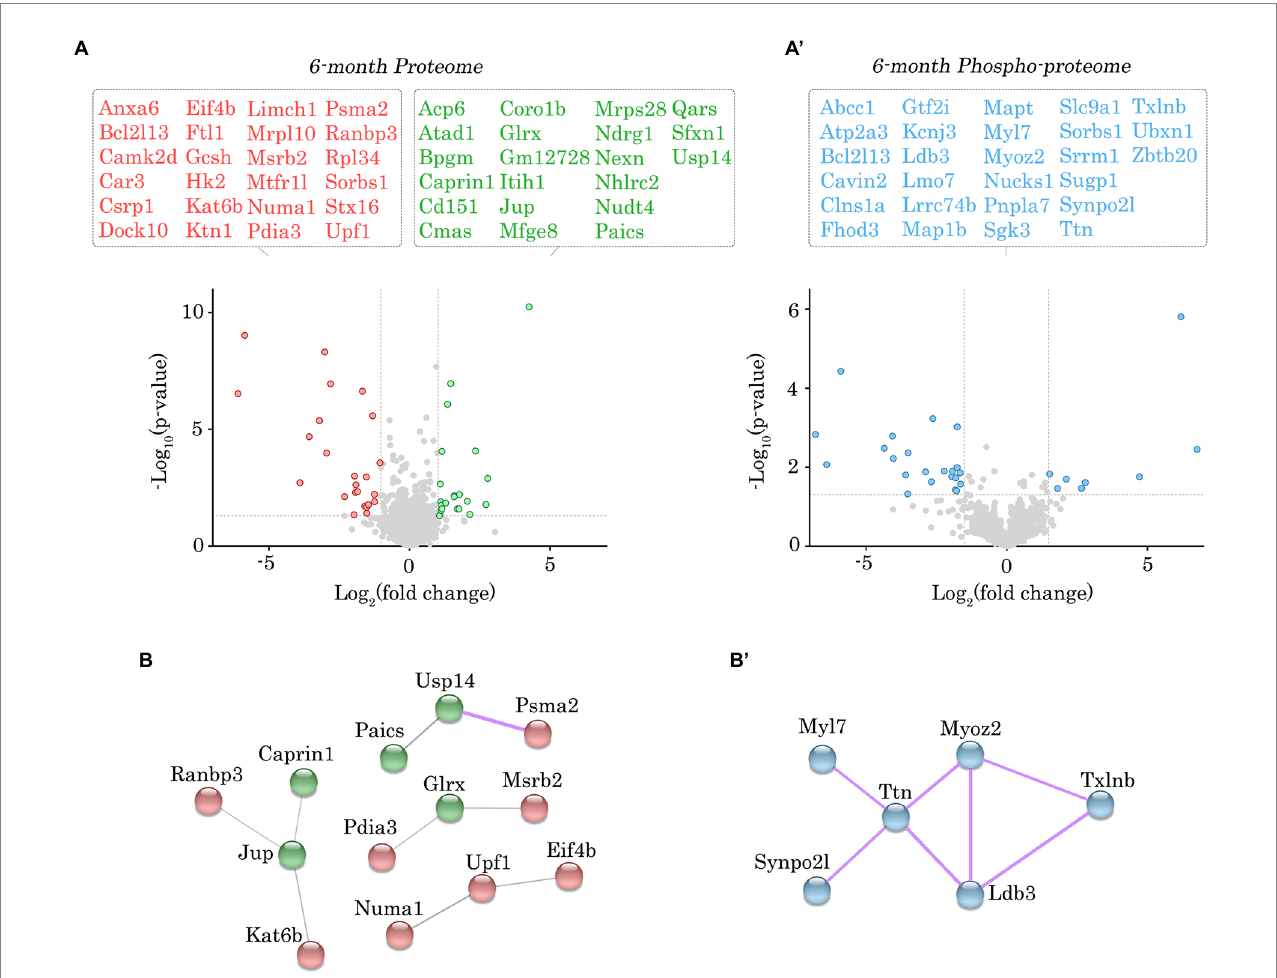
FIGURE 3 Proteomic and phospho-proteomic analysis of Obscn- Δ Ig58/59 atria at 6-months. (A,A’) Volcano plots of significantly up-regulated (green) or down- regulated (red) proteins (A) and significantly altered phospho-peptides (blue; A’ ) in Obscn- Δ Ig58/59 atria at 6-months. A total of 45 proteins out of 1700 detected exhibited significantly altered expression (A) , whereas 30 phospho-peptides out of 1,401 detected were significantly altered (A’) in 6-month-old Obscn- Δ Ig58/59 atria compared to wild-type; n = 5 biological samples per genotype; grey dotted lines represent thresholds of p < 0.05 and SD > 2. (B,B’) The physical and functional associations of the deregulated proteins (B) and phospho-proteins (B’) in Obscn- Δ Ig58/59 atria at 6-months were plotted using the STRING database (v.11.0b). Line thickness corresponds to the strength of the association. Protein networks with a high confidence score (>0.7) are highlighted in